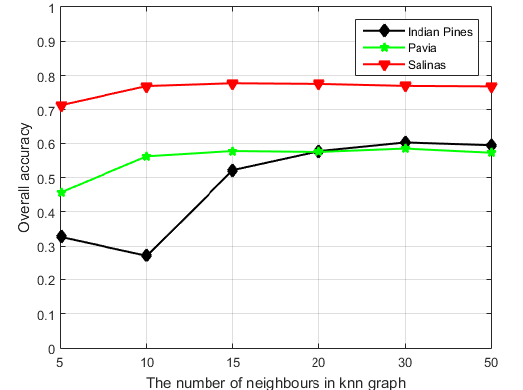
Figure 10. Performance of the proposed method with respect to the number of neighbours k in K-nearest neighbors (KNN)